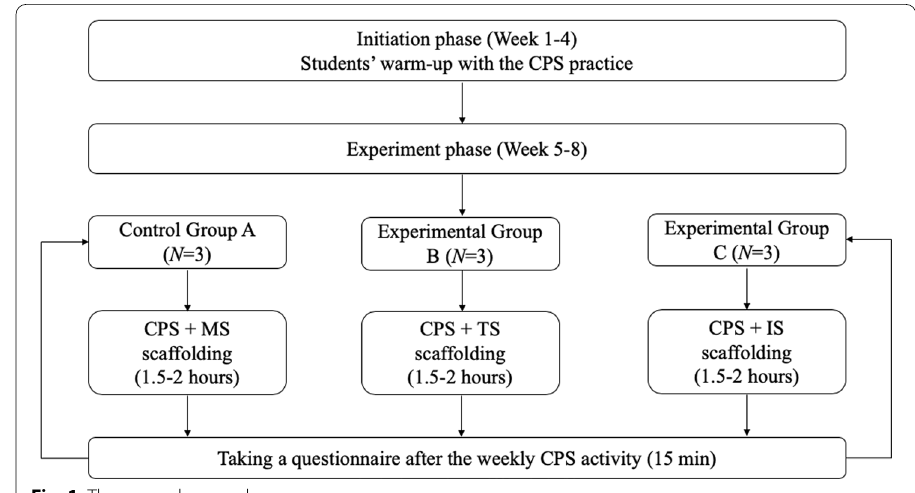
Fig. 1 The research